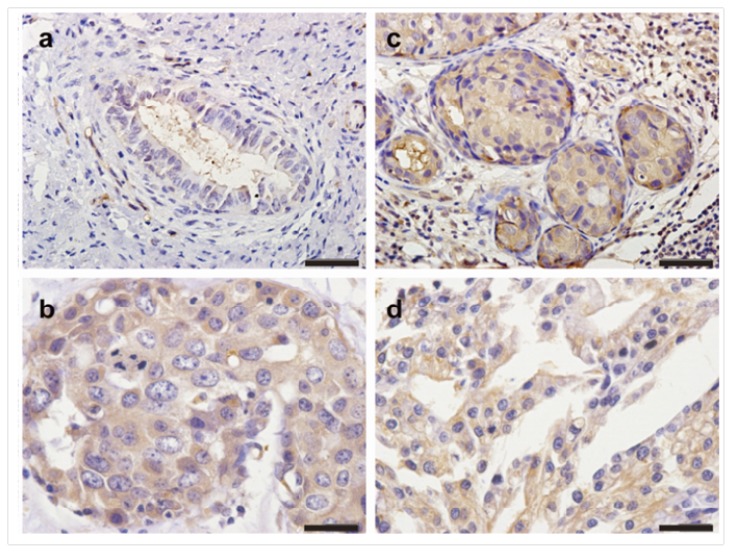
Immunohistochemical detection of TMPRSS4 expression in formalin-fixed paraffin-embedded triple-negative breast cancer (TNBC) tissue samples. (a) Negative TMPRSS4 immunostaining in another TNBC tissue; (b–d) Positive TMPRSS4 immunostaining in TNBC tissue. Positive TMPRSS4 immunostaining in TNBC tissues appeared as brown particles, which were mainly localized within the cytoplasm and cell membrane in the nests of breast cancers.